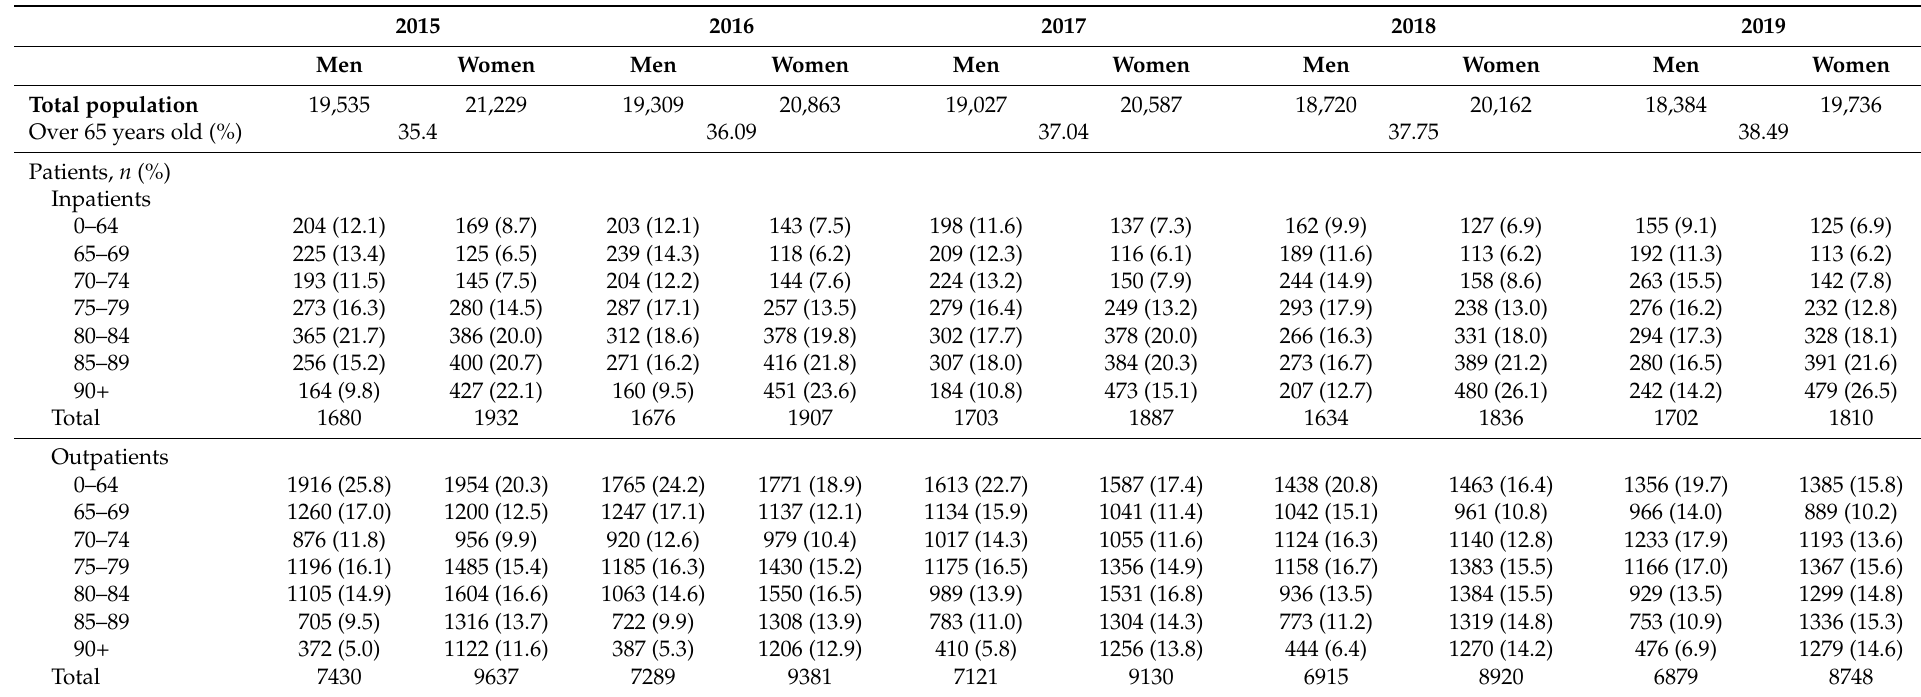
Table 1. Demographics of Unnan City residents and patients.